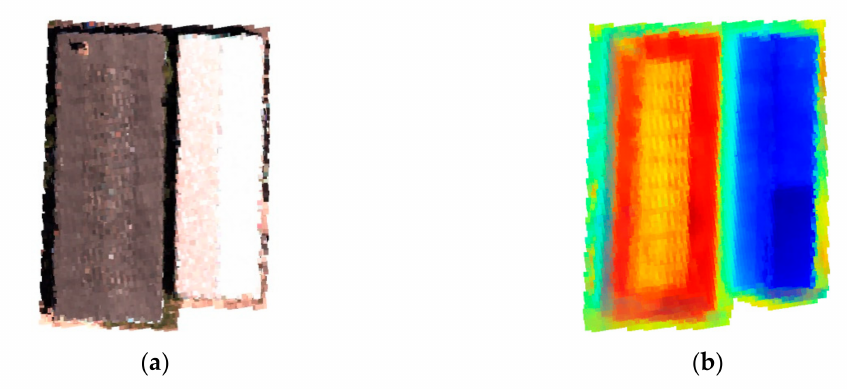
Figure 11. Potential building thermal leakage: ( a ) represents the reference RGB point cloud and ( b ) refers to the thermal texture mapping result ( ◦ C).